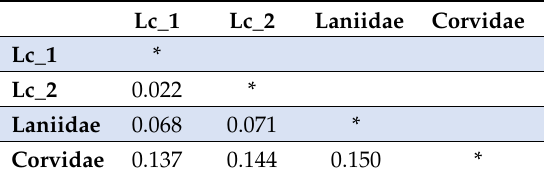
Table 3. Estimates of evolutionary divergence (base substitutions per site) over sequence pairs between the two main L. collurio clades, versus the other five Laniidae species and the